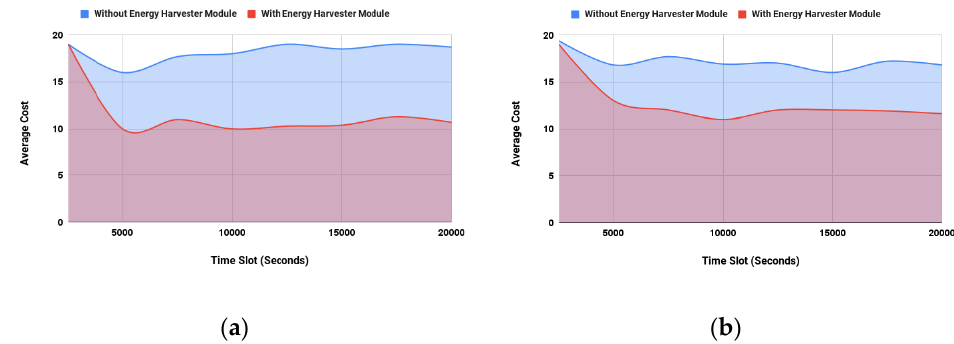
Figure 11. The system run-time costs in both online and offline modes. ( a ) Average cost for online mode. ( b ) Average cost for offline mode (Figure ( a ) is on the left, Figure ( b ) is on the right ( b )).